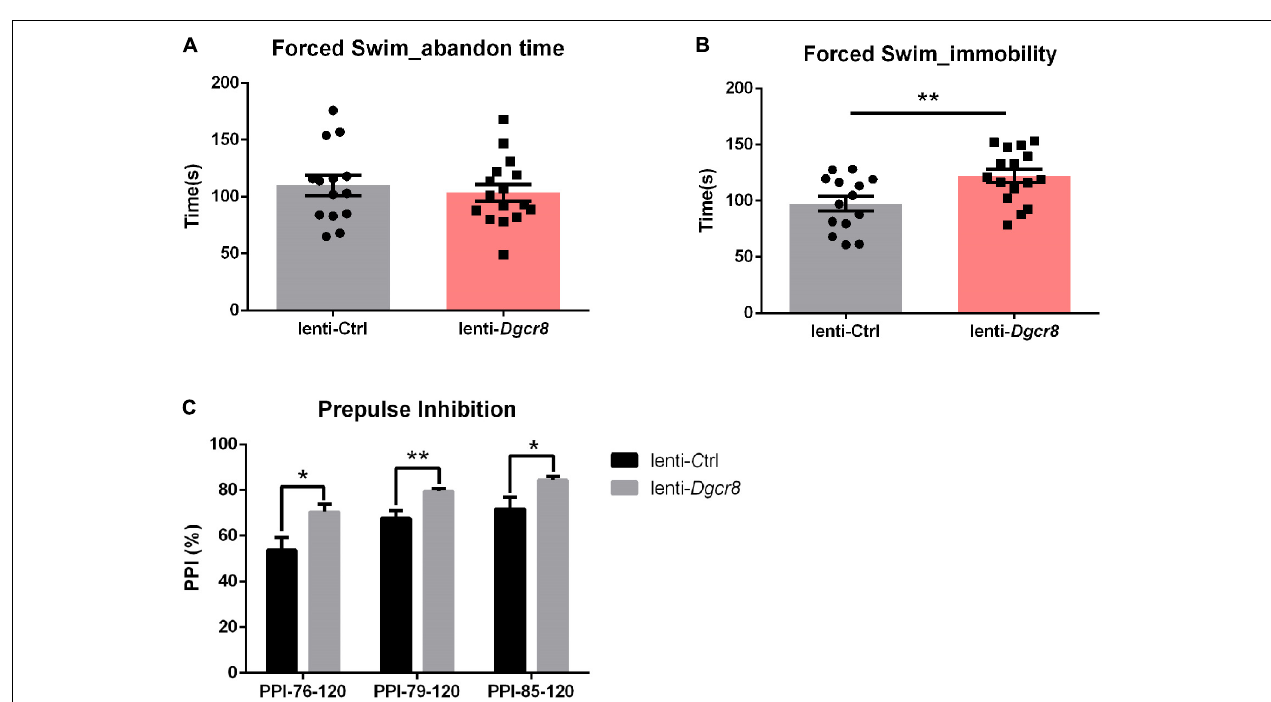
FIGURE 3 | Results of the forced swim test. (A) Abandon time showed no significant difference between two groups ( p = 0.5854). Abandon time: the time point when the mice initially gave up struggling in the water. (B) The case group showed more immobility than the control group ( p = 0.0092). Immobility: the total amount of time the mice floated in the water during the 5 min testing. N = 14 for lenti-Ctrl group and n = 16 for lenti- Dgcr8 group. Results were presented as means ± SEM. Owe-way ANOVA test. ** p < 0.01. (C) Results of the prepulse inhibition (PPI) test. The prepulse stimulus (76, 79, and 85 dB) and the startle stimulus (120 dB) were used. The case showed significant higher PPI than the control group for each prepulse. N = 14 for lenti-Ctrl group and n = 16 for lenti- Dgcr8 group. Results are presented as means ± SEM. Two-way ANOVA test. * p < 0.05, ** p <